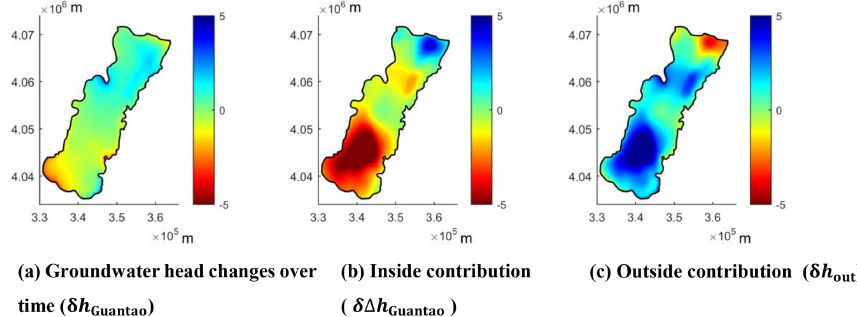
Figure 12. Spatial distribution of changes in groundwater head over the modeled time span and its